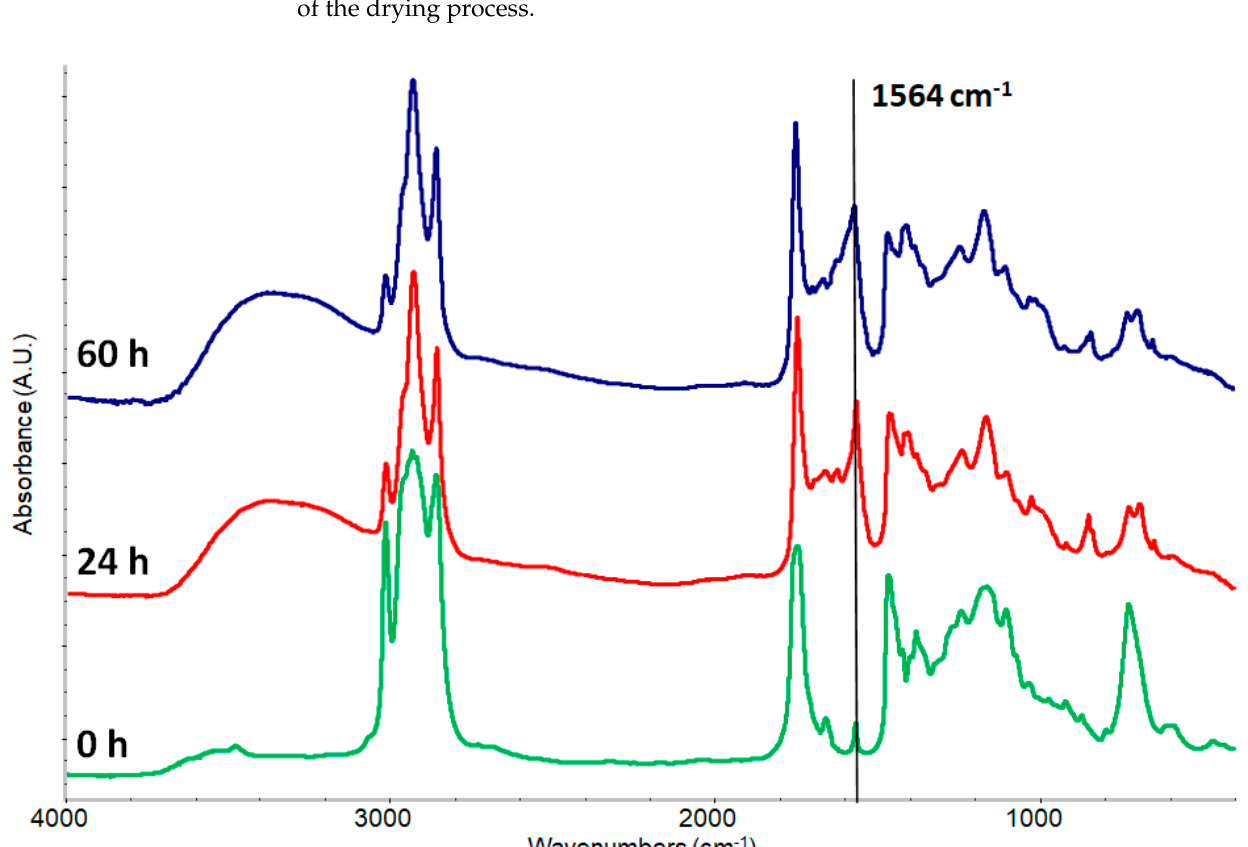
Figure 2. Kinetics of potassium carboxylate formation from a mixture 1:1 ( w / w ) of stand oil and KOH. The black arrow shows the carboxylate band.